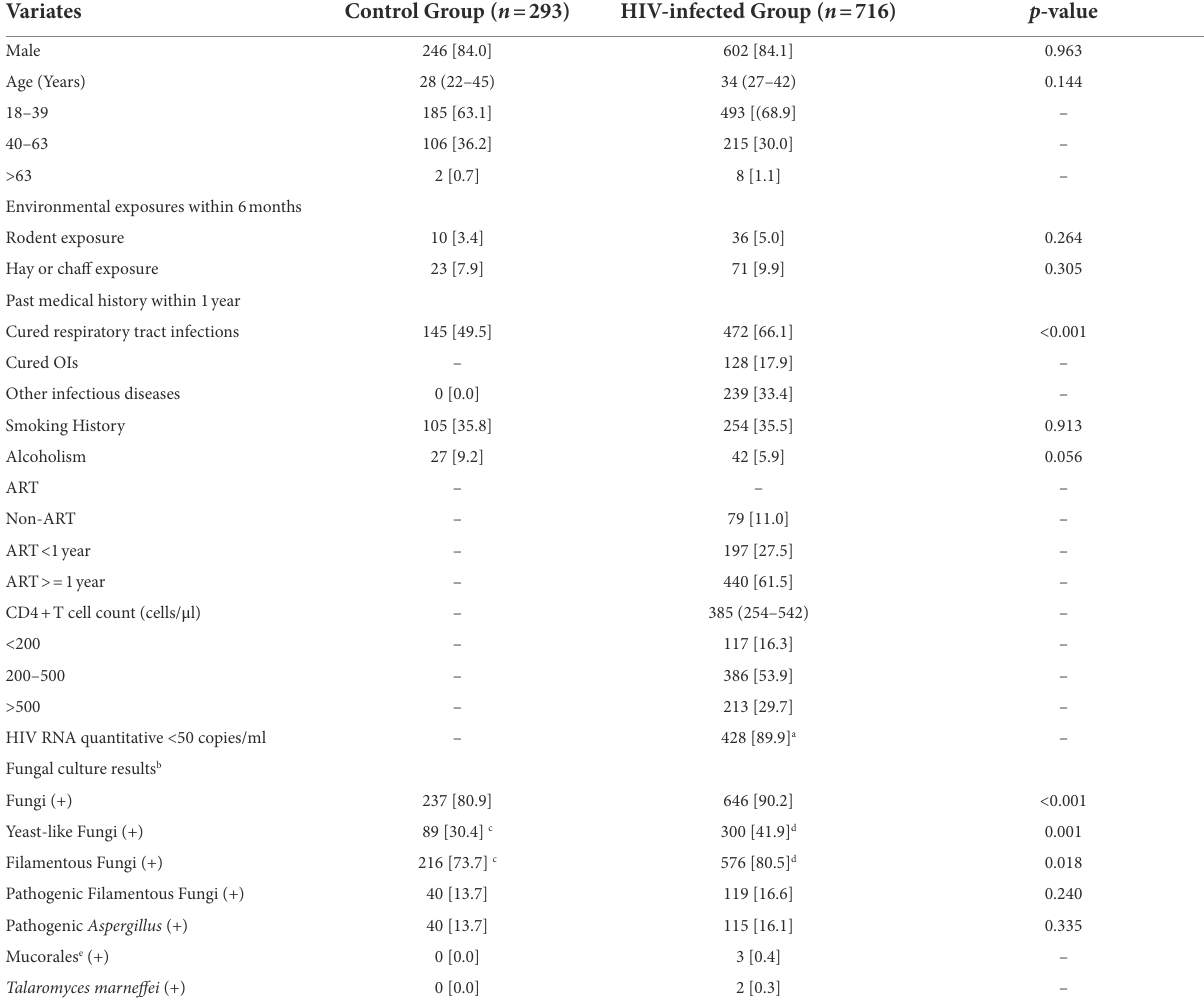
TABLE 1 Comparison of baseline characteristics and fungal positive rates between the HIV-infected group and the control group.